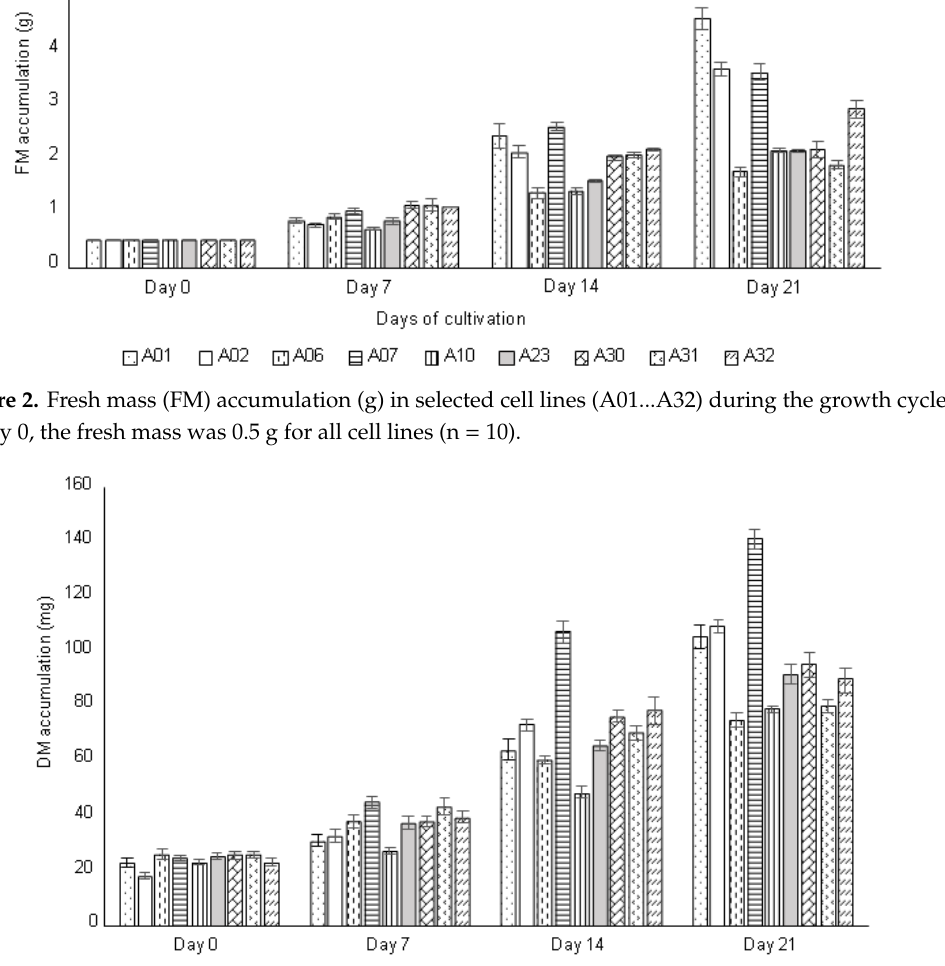
Figure 3. Dry mass (DM) accumulation (mg) in selected cell lines (A01...A32) during the growth cycle (n = 10).